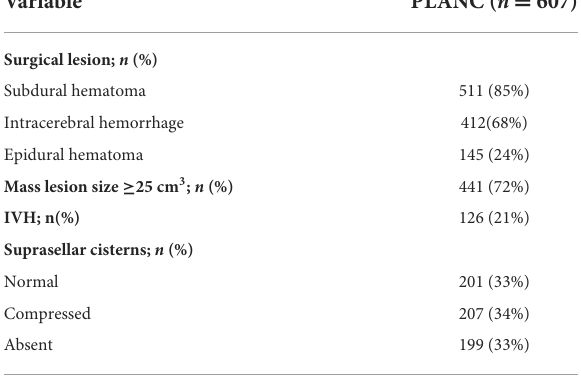
TABLE 1 Surgical and computerized tomography characteristics of the PLANC cohorts a . Variable PLANC ( n =